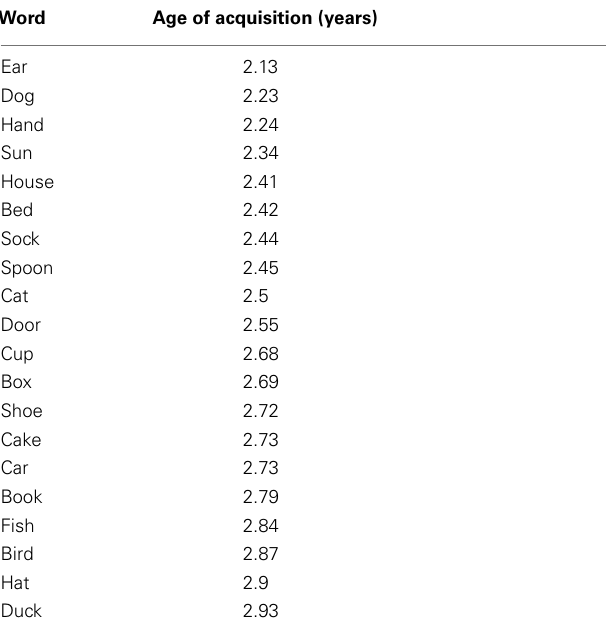
Table 1 | Pictures used in the naming task